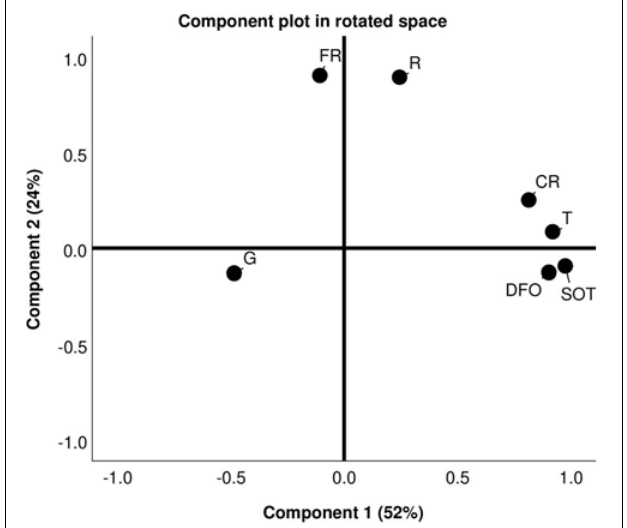
FIGURE 2 | Principal component analysis graph showing the monthly values of germination percentages (G), temperatures (T), sum of temperatures (SOT), rainfall (R), cumulated rainfall (CR), and frequency of rainfall (FR) of MT vineyard between year 1 and 4.